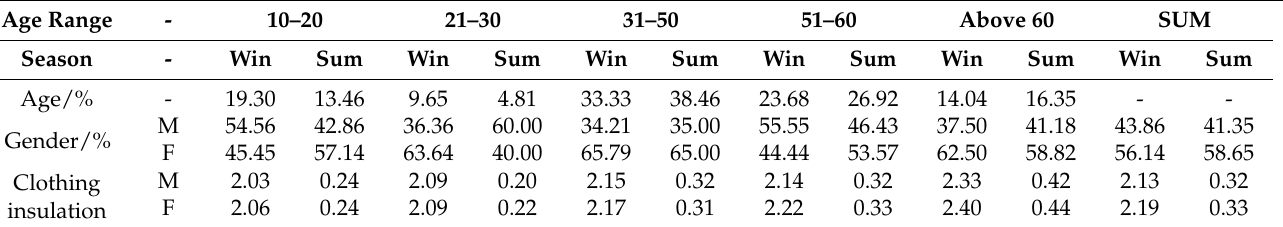
Table 3. The basic information of subjects.